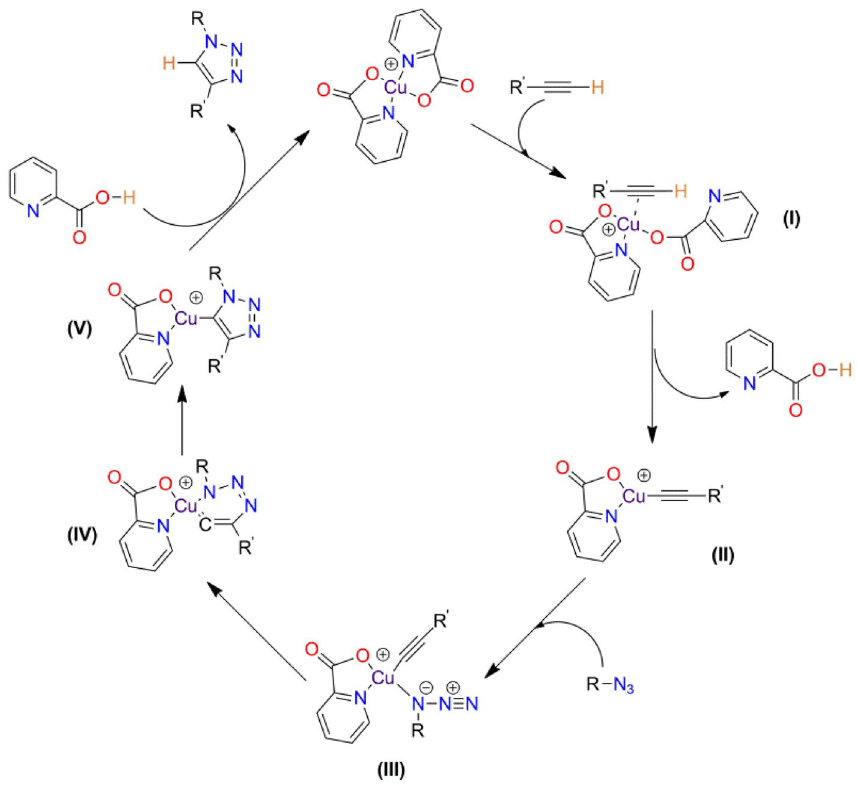
Figure 3. Proposed reaction mechanism of CP1 in